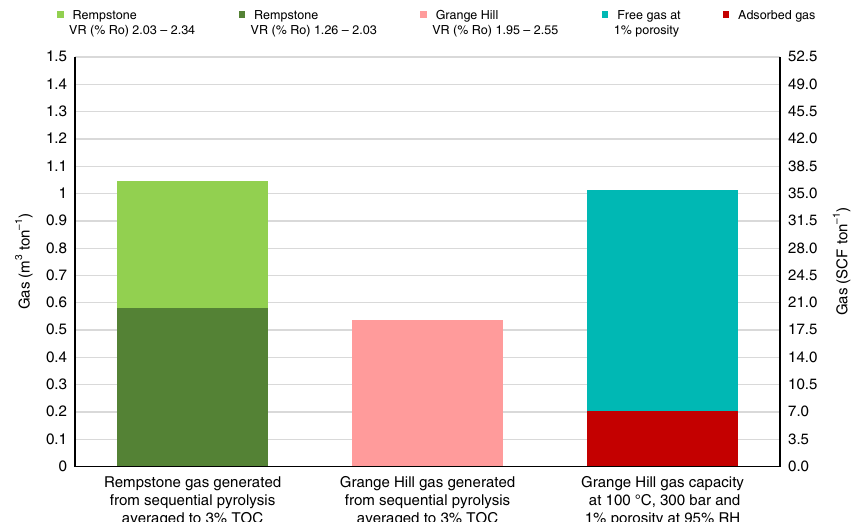
Fig. 7 Comparison of gas generated at %Ro >1.3 and shale holding capacity (free plus adsorbed gas) based on the results for Rempstone and Grange Hill shales normalised to 3% TOC (TOC after stage 5 of HPWP for Grange cylindrical pressure vessel rated to 1400 bar at 420 °C, connected to a pressure gauge and rupture disc rated to 950 bar. Heat was applied by means of a fl uidised sand bath, controlled by an external temperature controller. The sand bath (con- nected to a compressed air source) was pre-heated to the required experimental temperature and left to equilibrate before the start of each run. For all experiments, after the addition of sample and water (for runs with water added) to the rector and reactor assembly, the reaction vessel system was fl ushed with nitrogen gas to replace air in the reactor head space. After which 2bar pressure of nitrogen was pumped into the pressure vessel system to produce an inert atmosphere during the pyrolysis runs. The 300bar experiments at 350 and 380 °C were performed by initially fi lling the vessel with 15ml distilled water, after which the pressure vessel was then lowered into the sand bath and allowed to attain vapour pressures of 175 and 235 bar at 350 and 380 °C, respectively, before the addition of excess distilled water via a compressed air driven liquid pump to increase the pressure to 300 bar. The 300 bar run at 420 °C was conducted by adding 10ml distilled water to the vessel, the expansion of the water gave the required pressure and the experiment was not pressurised. The 800 bar experiment at all temperatures were performed similarly to the 300 bar runs at 350 and 380 °C, also fi lling the vessel initially with 15ml distilled water before increasing the pressure to 800 bar. The anhydrous experiment